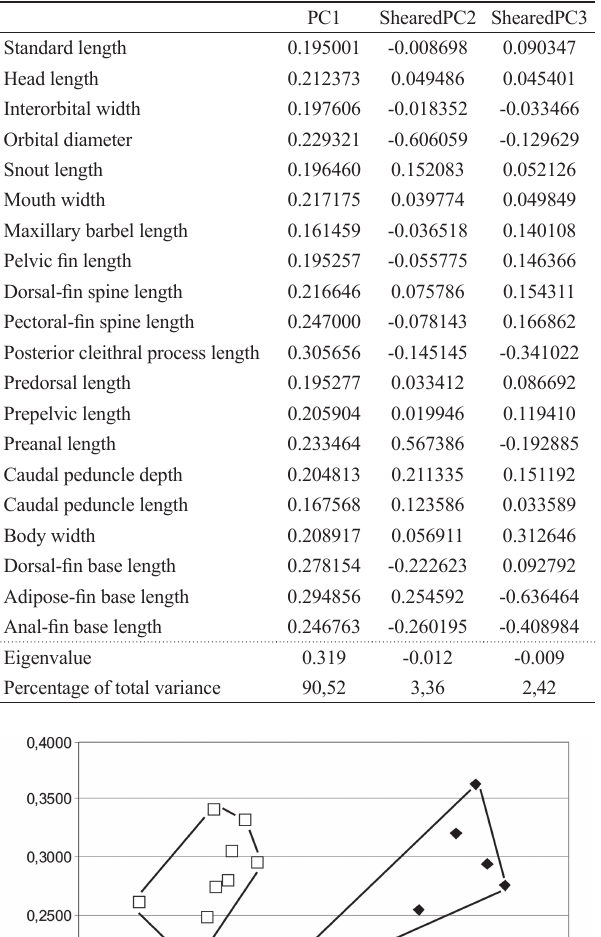
Table 2. Loadings of characters, eigenvalue and percentages of variance on first three Principal Components axis (PC1- PC3), from the analysis of combined samples of Microglanis leniceae (n = 6), M. carlae (n = 9) and M. cottoides (n = 7).